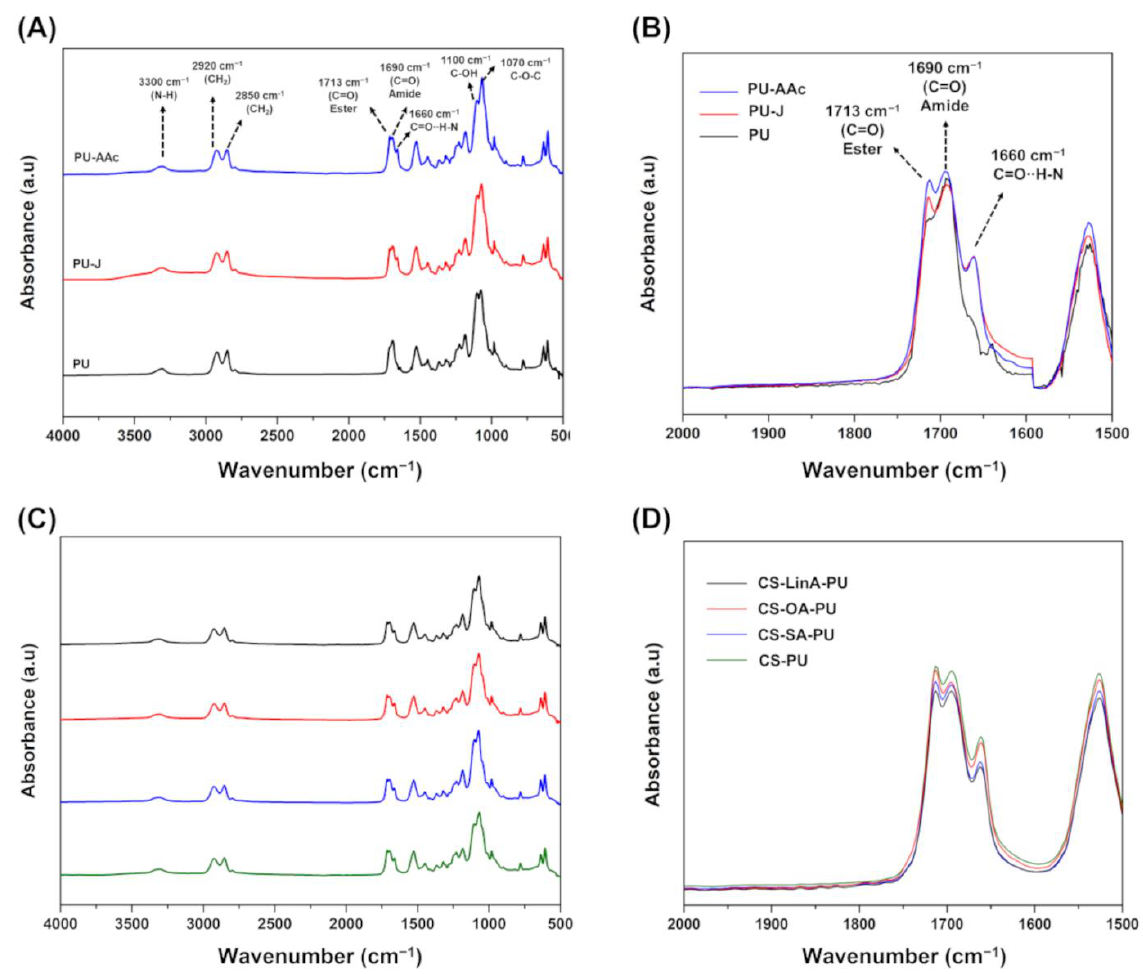
Figure 8. FTIR-ATR spectra of untreated PU stent, PU stent treated by Jone’s reagent (PU-J), acrylic acid-modified PU stent (PU-AAc) ( A ); magnified region from 2000 cm − 1 to 1500 cm − 1 of untreated PU stent, PU-J and PU-AAc ( B ); CS and CS-FA coated-PU stents ( C ); magnified region from 2000 cm − 1 to 1500 cm − 1 of CS and CS-FA coated-PU stents ( D ).